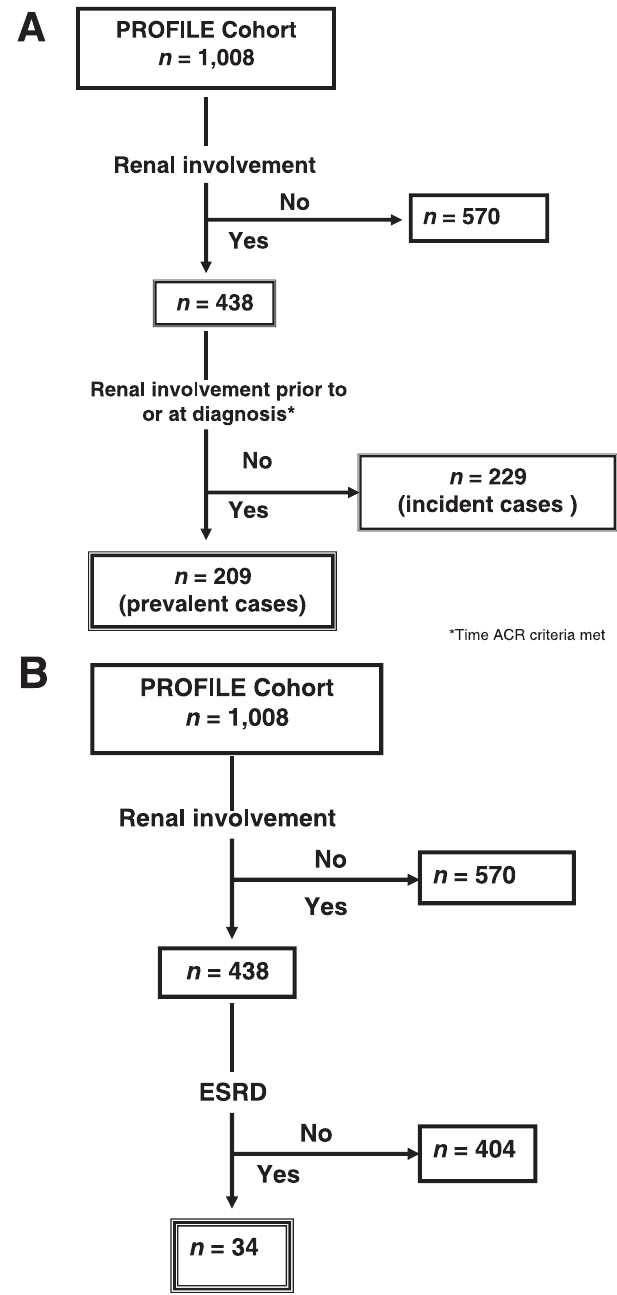
Figure 1. Flow Diagram of PROFILE Cohort Patients Included in Analyses (A) Renal involvement (double-lined boxes). (B) ESRD (triple-lined box). DOI: